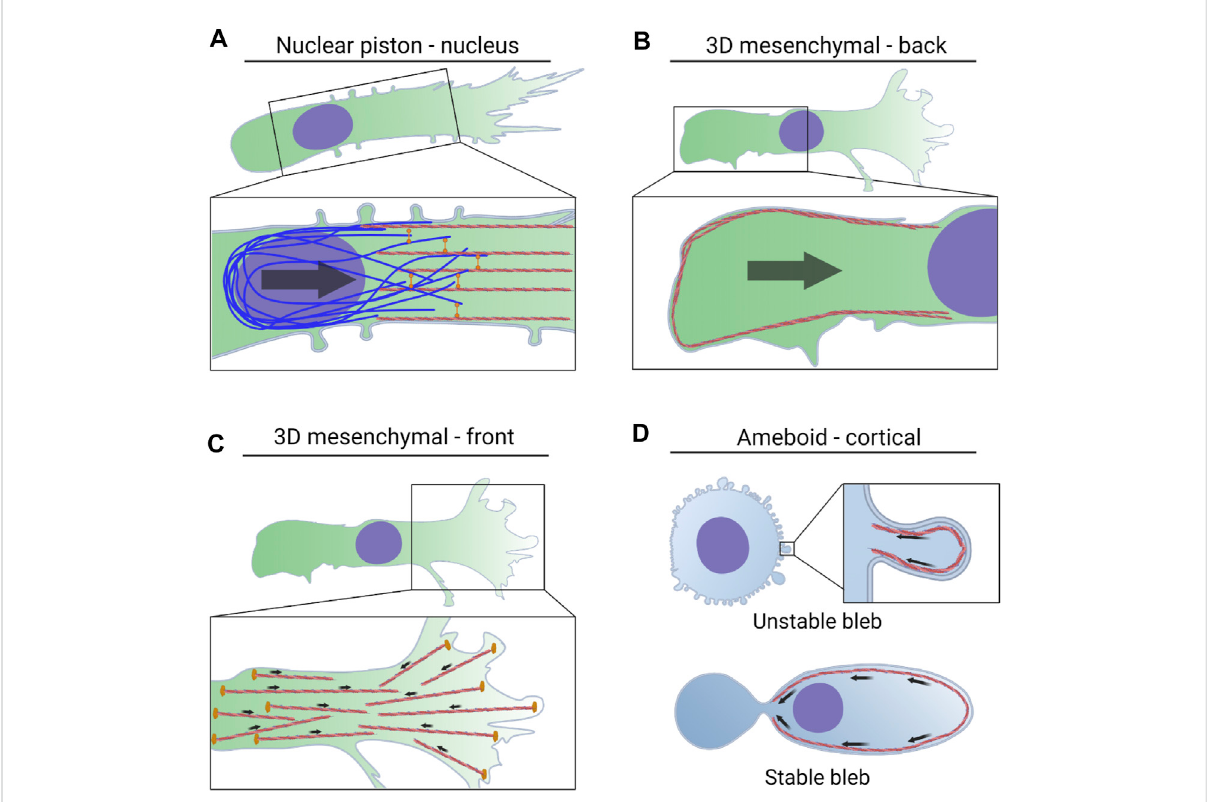
FIGURE 2 NMIIactivitypowersmultiplemodesof3Dcellmigrationviadistinctmechanisms. (A) .Actomyosincontractilityinthefrontofthecellisattached tovimentinintermediate fi lamentsbytheplectincrosslinker.Theforcegeneratedbythismachineryistransmittedtothenucleusvianesprin3tohelp pull the nucleus through 3D matrices. The forward movement of the nucleus increases cytoplasmic pressure to form lobopodial protrusions. (B) . NMII activity at the trailing edge is regulated by mechanical stress on the nucleus, tension within the plasma membrane, and the small GTPase RhoA.Thisactomyosincontractilityincreasespressureattherearofthecellanddriveswaterintothenucleuswhichcanleadtoblebbingandrupture ofthenuclear envelope. (C) . NMII activity inleading protrusionscan transmit traction forcesto thesurroundingECM. This helps to align matrix fi bers immediately in front of the cell to promote directional movement. (D) . Actomyosin contractility in the cortex increases pressure in amoeboid cells forming small, unstable blebs. NMII-driven retrograde fl ow propels cells forming stable blebs forward through preexisting